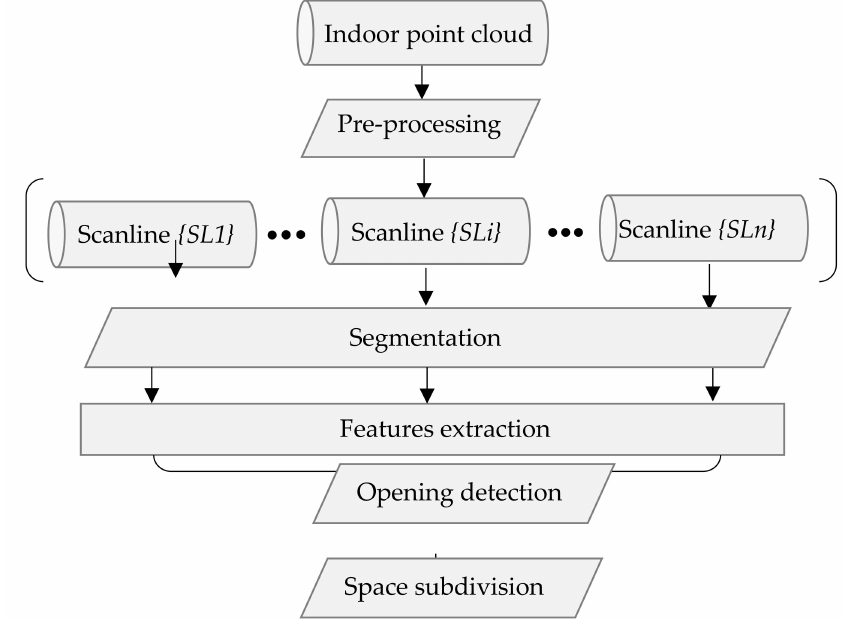
Figure 2. Workflow of proposed methodology.